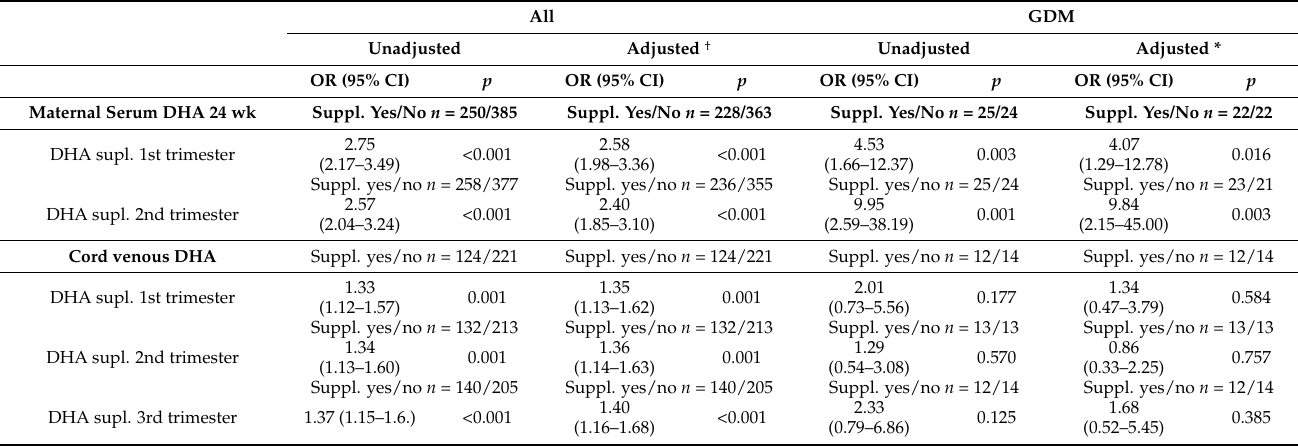
Table 6. Logistic regression analysis assessing the odds of having different response to dietary DHA supplements in pregnancies affected by gestational diabetes mellitus. The NELA study (2015–2018).